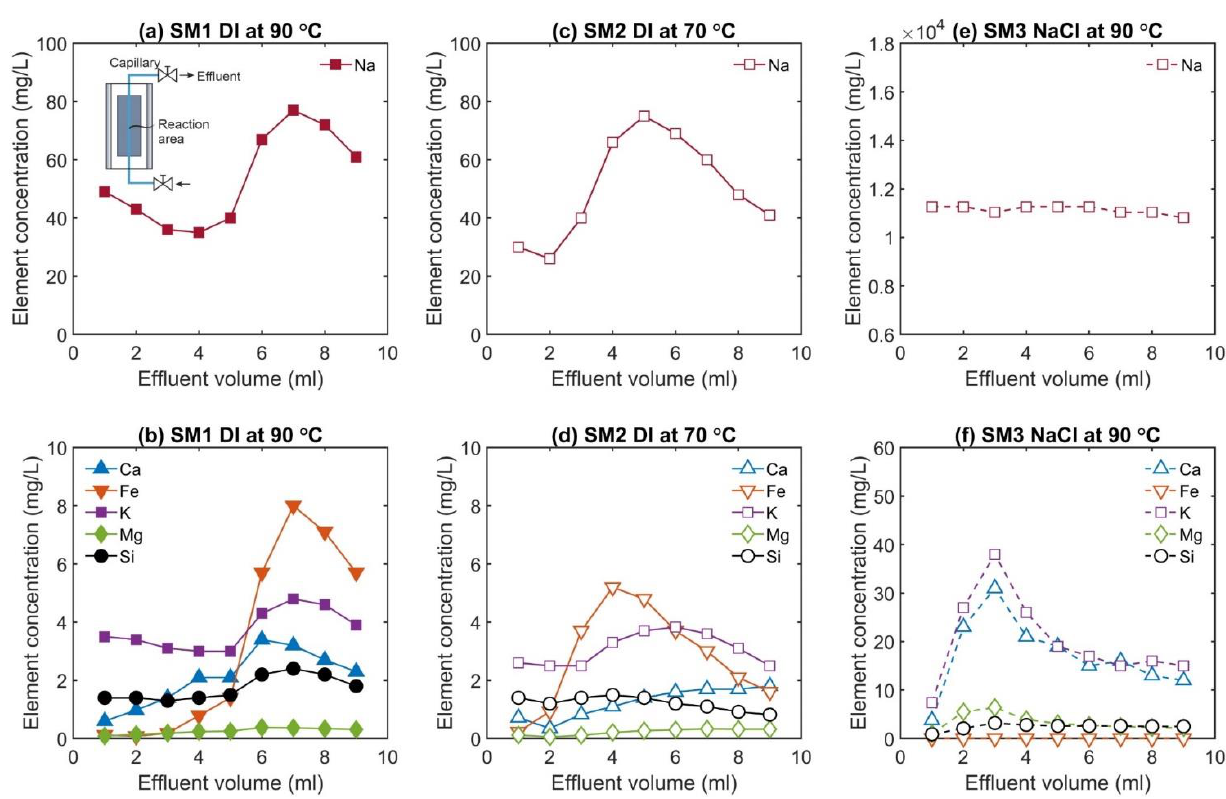
Figure 6. Effluent element concentrations of subsamples after the first time interval of 6 days in SM1 ( a , b ), SM2 ( c , d ), SM3 ( e , f ). Peak values indicate fluid composition extracted from the fracture aperture, while the other subsamples include fluid within the capillaries adjacent to the sample. Note the different scales of Na concentrations.